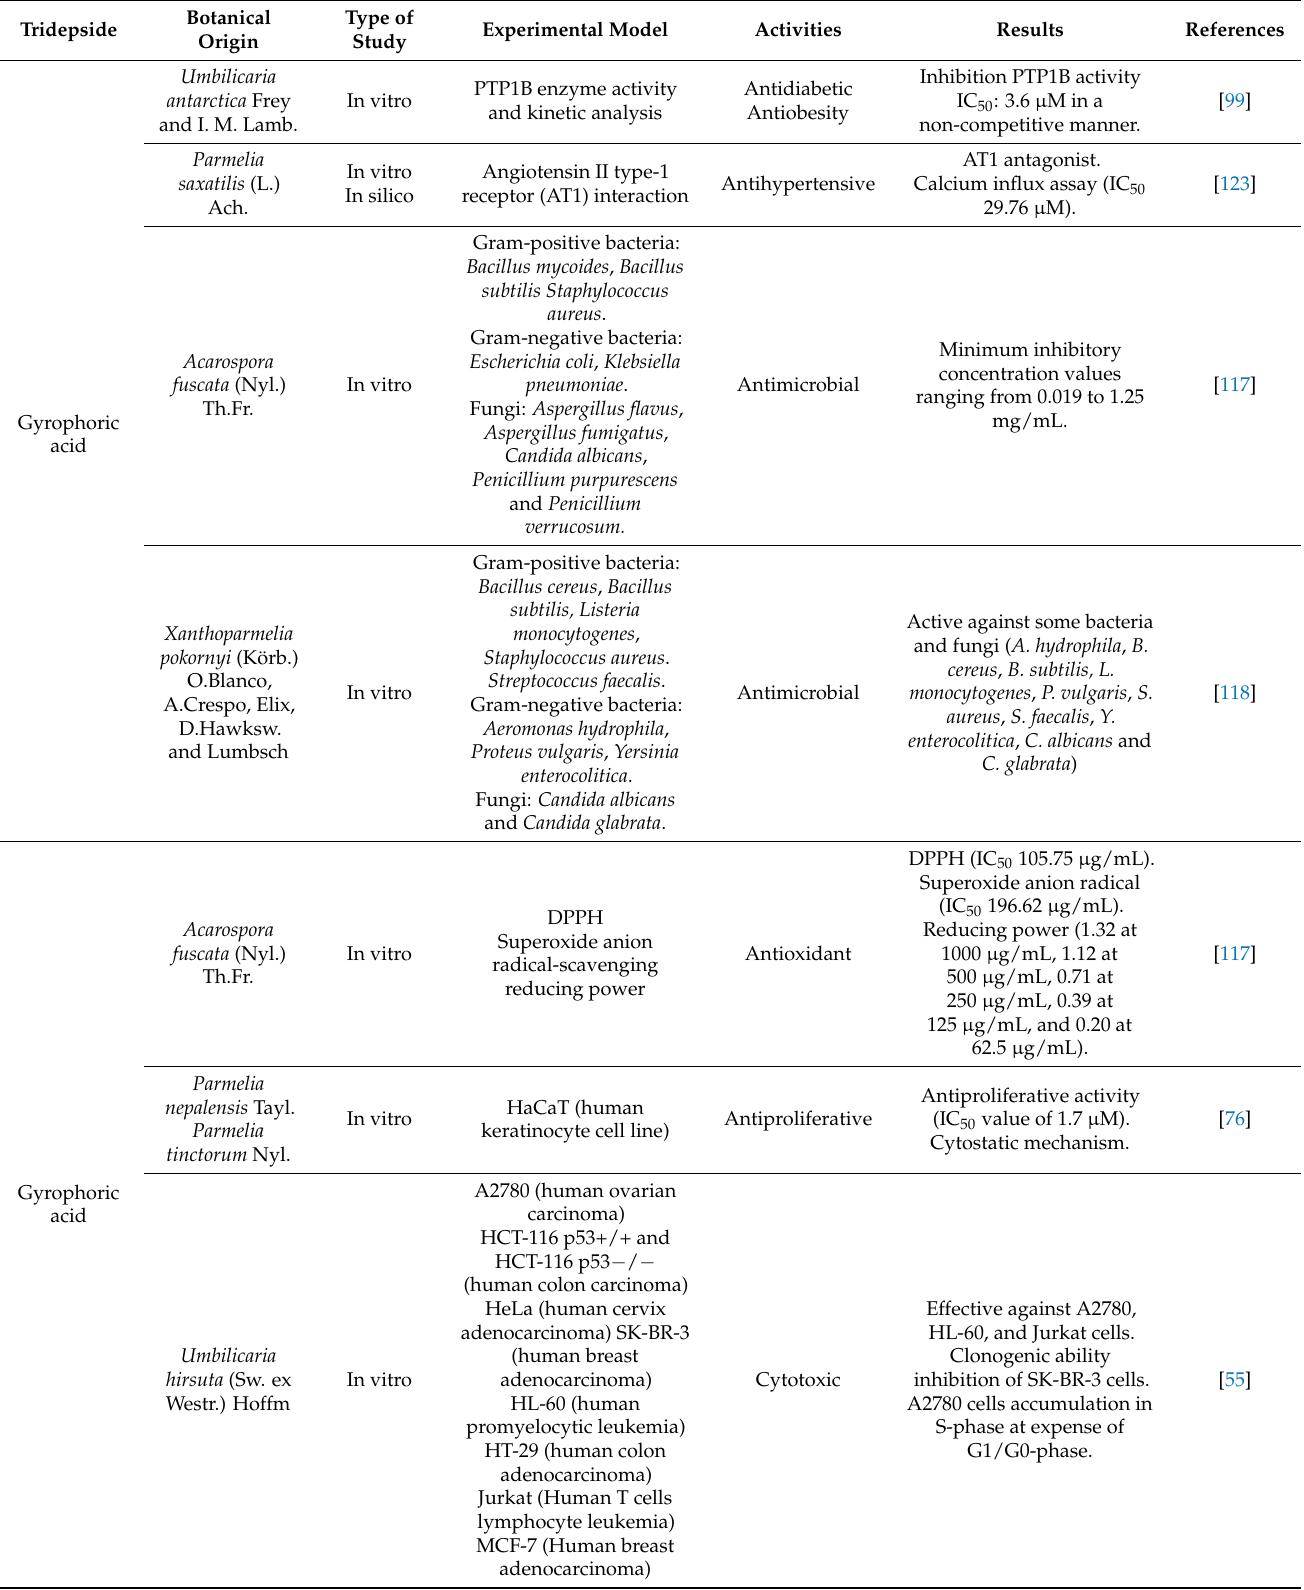
Table 2. Pharmacological activity of lichen